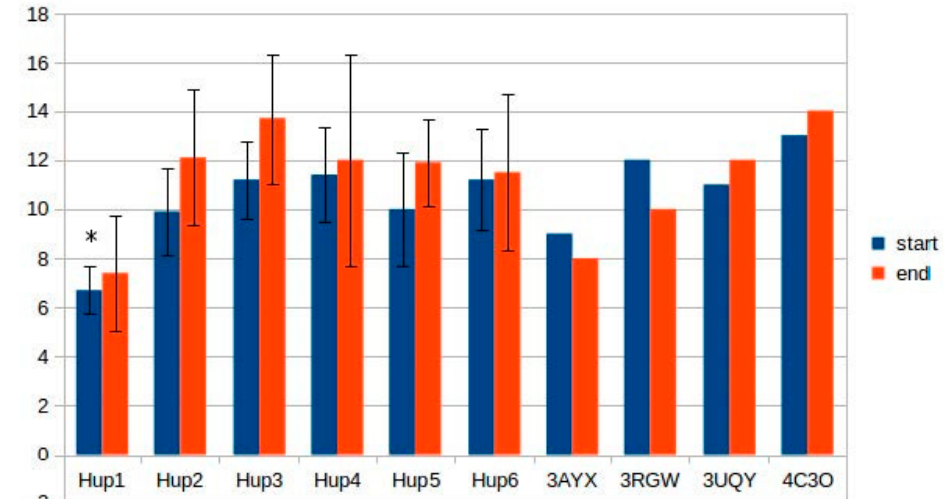
Figure 11. Number of ionic pairs between the subunits of HupSL hydrogenases. Hup1 -HupSL from Tca. roseopersicina ; Hup2 -HupSL from Rba. capsulatus ; Hup3 -HupSL from Rba. sphaeroides ; Hup4 -HupSL from Rps. palustris ; Hup5 -HupSL from Rvi. gelatinosus ; Hup6 -HupSL from Rsp. rubrum ; 3AYX -HoxKG from H. marinus ; 3RGW -HoxKG from R. eutropha ; 3UQY -HyaAB from E. coli ; 4C3O -HydAB from S. enterica. Start-models (structures) before energy minimization; end-models (structures) after energy minimization. The data are represented as mean ± 2 × SD. Significantly low results (ranges not overlapping with the others in the subgroup) are marked by asterisks.